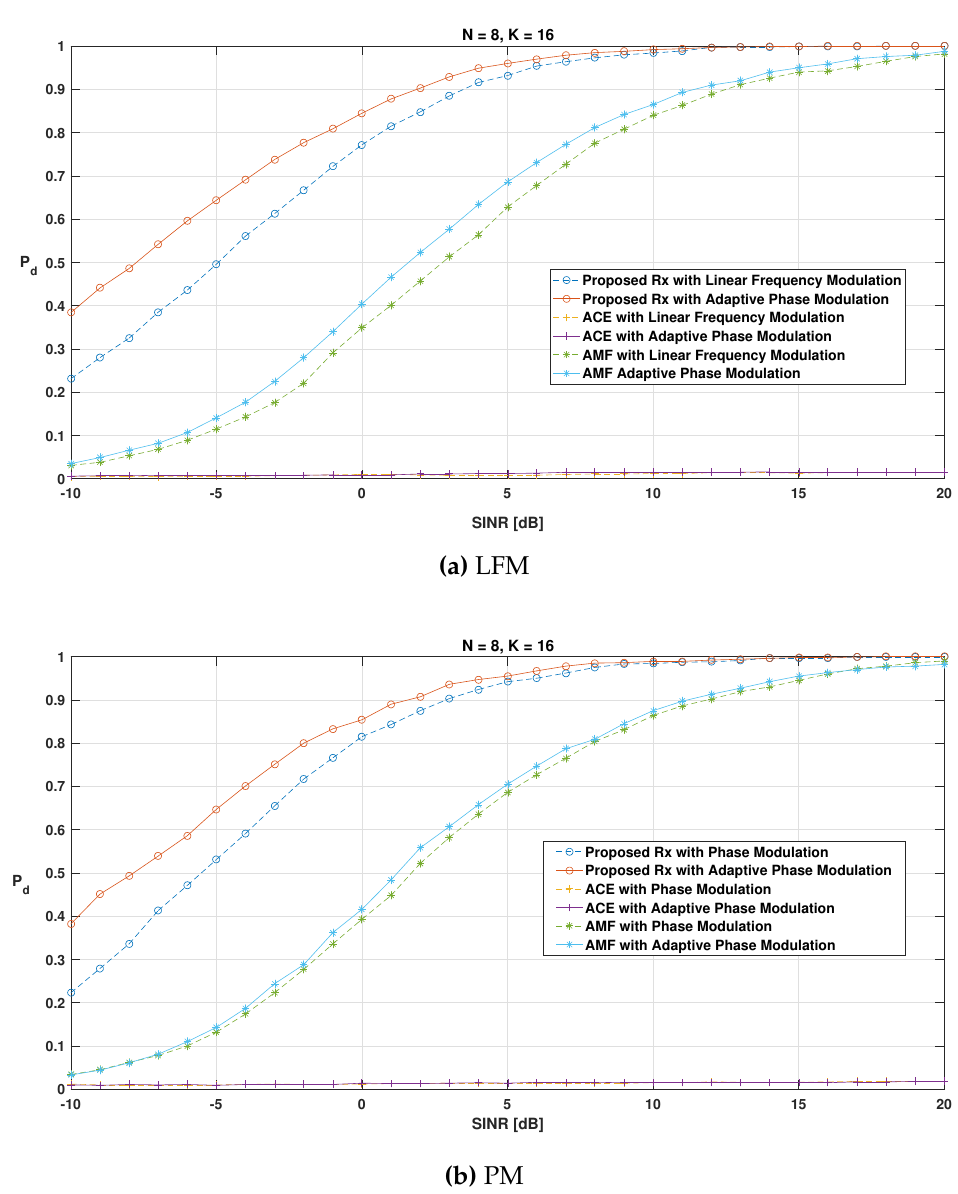
Figure 3. P d versus SINR curves at the end of Sub-dwell 1 (LFM) and using adaptive phase modulated waveform design in Sub-dwell 2 (APM); N = 8, K = 16, P fa = 10 − 2 , L =